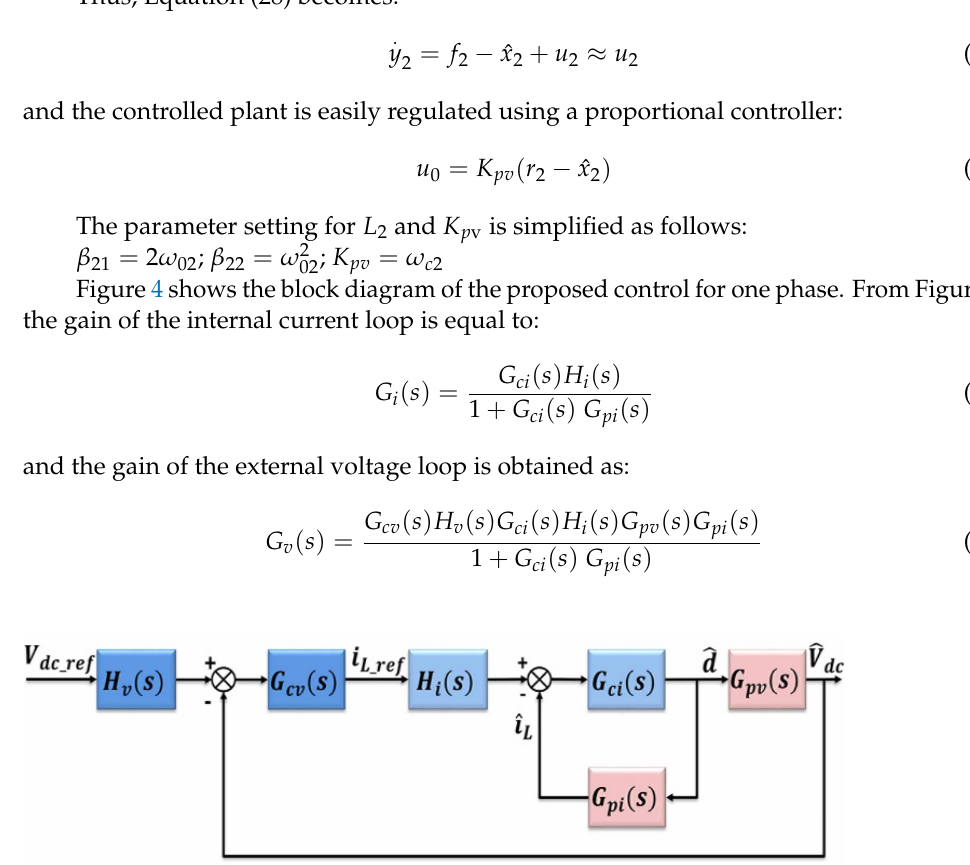
Figure 4. Control structure of IHGBC for one phase.